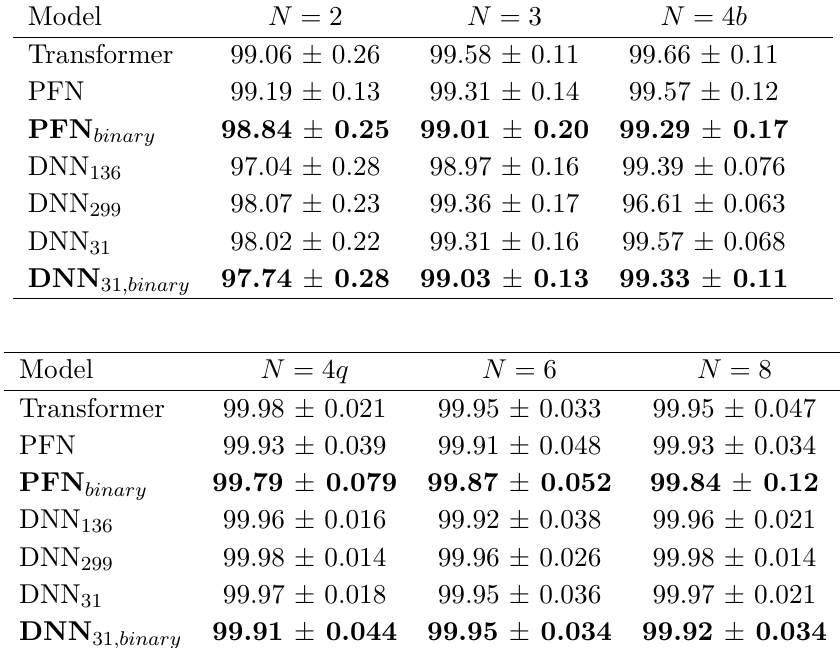
Table 3 . ROC-AUC percentage score for classifying jets with N = k versus N = 1 hard sub-jets, averaged over results from 10-fold cross validation.